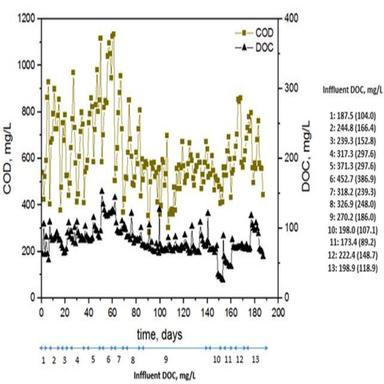
DOC and COD evolution during the bio-treatment of pre-treated landfill leachate in FBR operated in batch mode. DOC contribution (in mg/L) from landfill leachate in each batch is shown in parentheses.